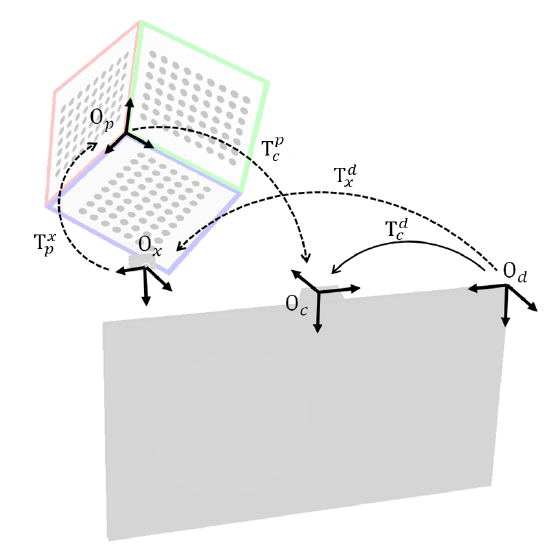
Figure 7. Coordinate systems with respect to each device of the ETAD. The arrow with solid line is the direct pose estimation. The arrows with dashed lines are paths of indirect pose estimation.